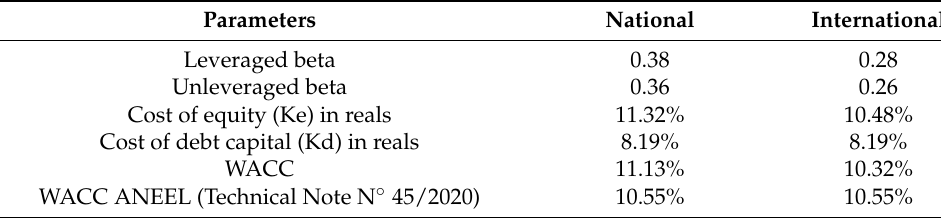
Table 3. Cost of privately held local and international thermoelectric